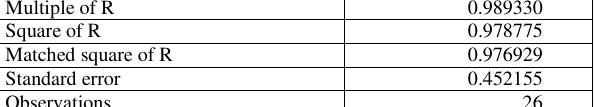
Table 3. Regression statistics of the equation (12) in relation to fuel con- sumption model of cars with spark ignition engines